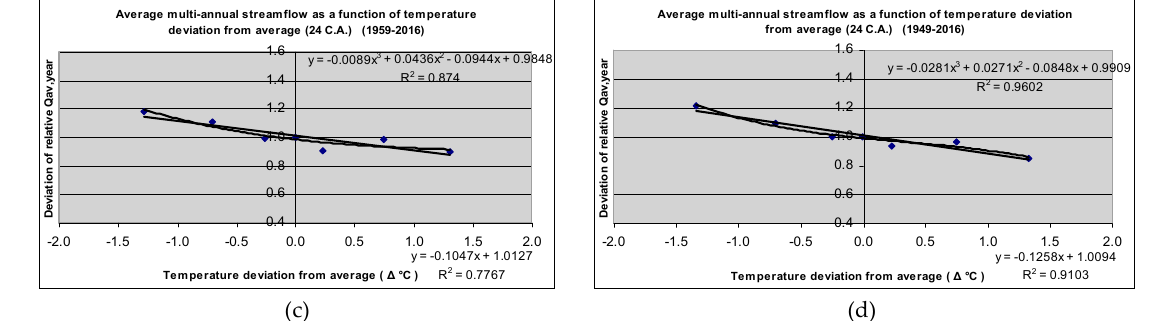
Figure 4. Average relative annual river discharge, as a function of temperature deviation. Figure 4a presents obtained correlation for period 1949–2006 in the 1st researching step (all 18 C.A.s). Figure